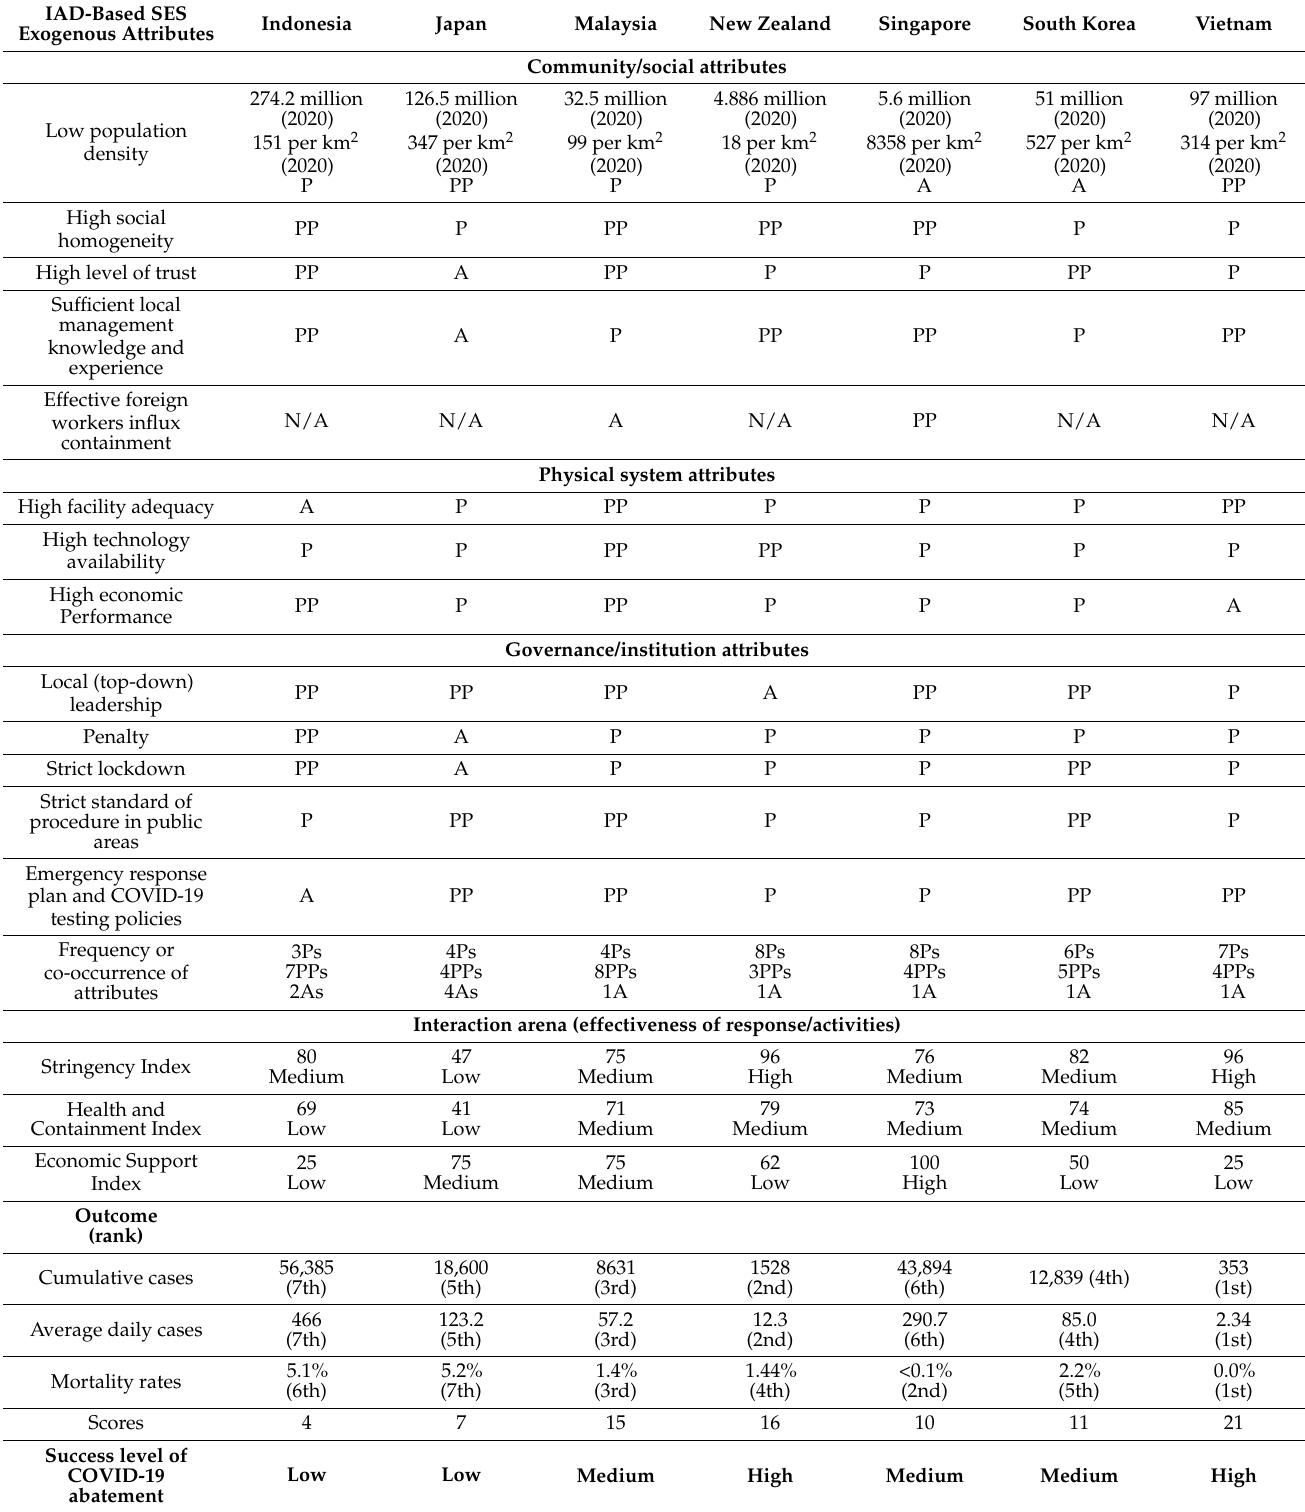
of the considerations. Table 5. A comparative analysis of institutional–social–ecological attributes for explaining the seven countries’ interaction and